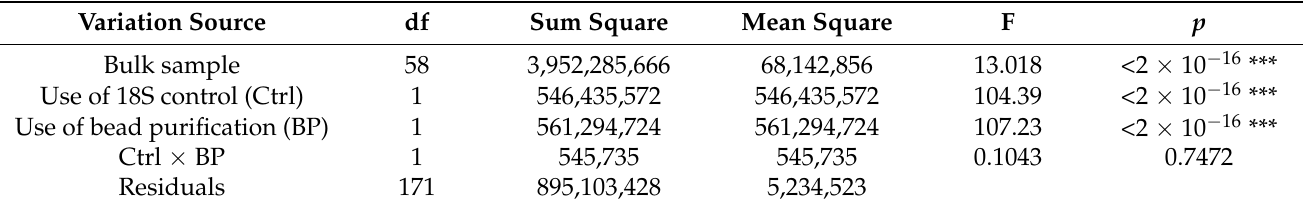
Table 6. Analysis of variance table of end RFU values for samples with and without bead purification (BP) and presence and absence of 18S control primers and probe (Ctrl) as well as the interaction between the two factors (Ctrl × BP).